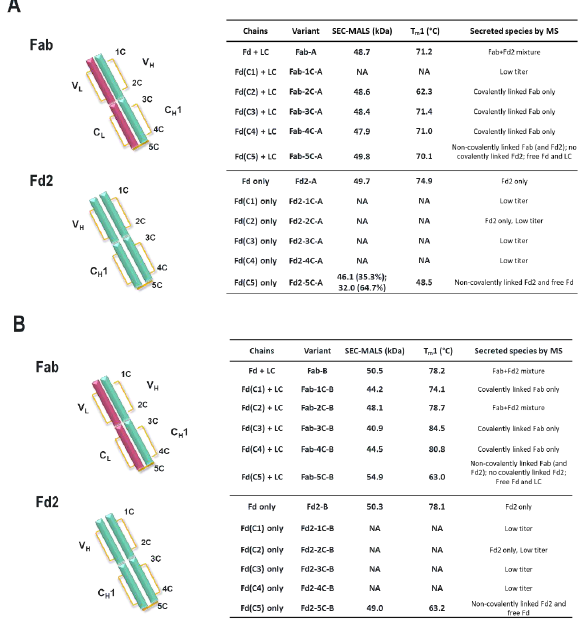
Figure 5. Diagrams of the Fab and Fd2 domains along with tabulation of transfected chains, variants, and SEC-MALS Mw and nano-DSF T m 1 results for both molecules A ( A ) and B ( B ). The Fab domain is shown as the assembly of the LC (V L + C L , red) and Fd (V H + C H 1, cyan). The Fd2 domain is also shown as a homodimer of Fd domains (cyan). Like in Figure 4A, disulfide bonds are depicted in yellow and the position of each cysteine is labeled 1C-5C counting from the N-terminus. Under the variant column is specified which cysteine is mutated to serine (e.g., Fab-1C-A has the first cysteine from N-terminus mutated to serine). Species identified by intact mass are listed. “NA” denotes no measurement since insufficient material was expressed and purified for characterization.